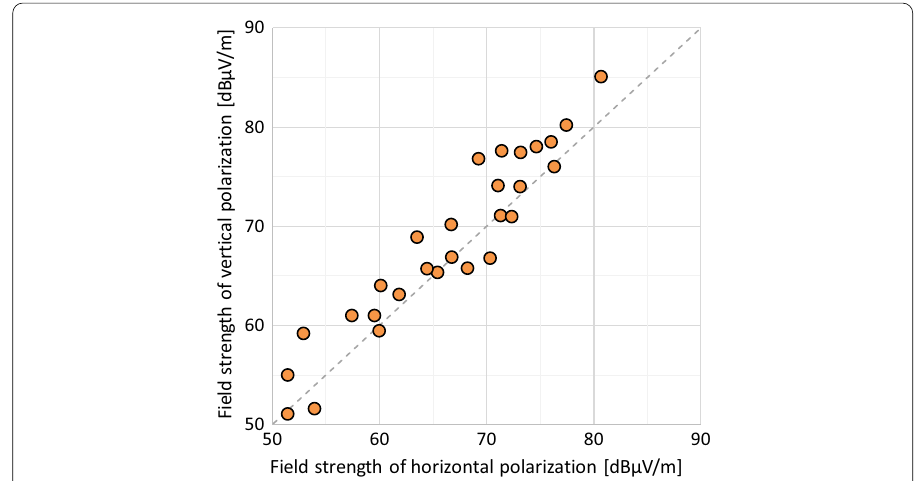
Fig. 13 Distribution of field strength of horizontal and vertical polarization in field experiments